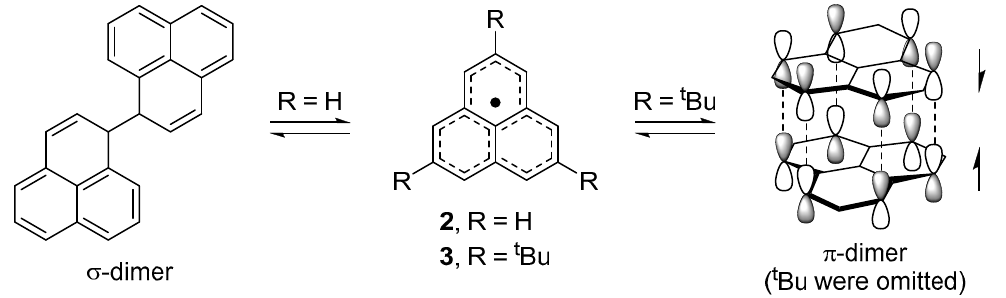
Figure 2. Dimerization mode of phenalenyl radicals.